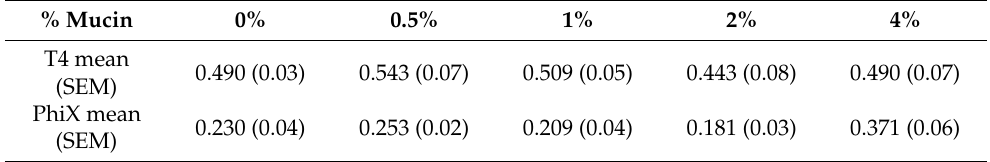
Table 5. Fold change in E. coli growth relative to control in static system with phage (MOI 100).